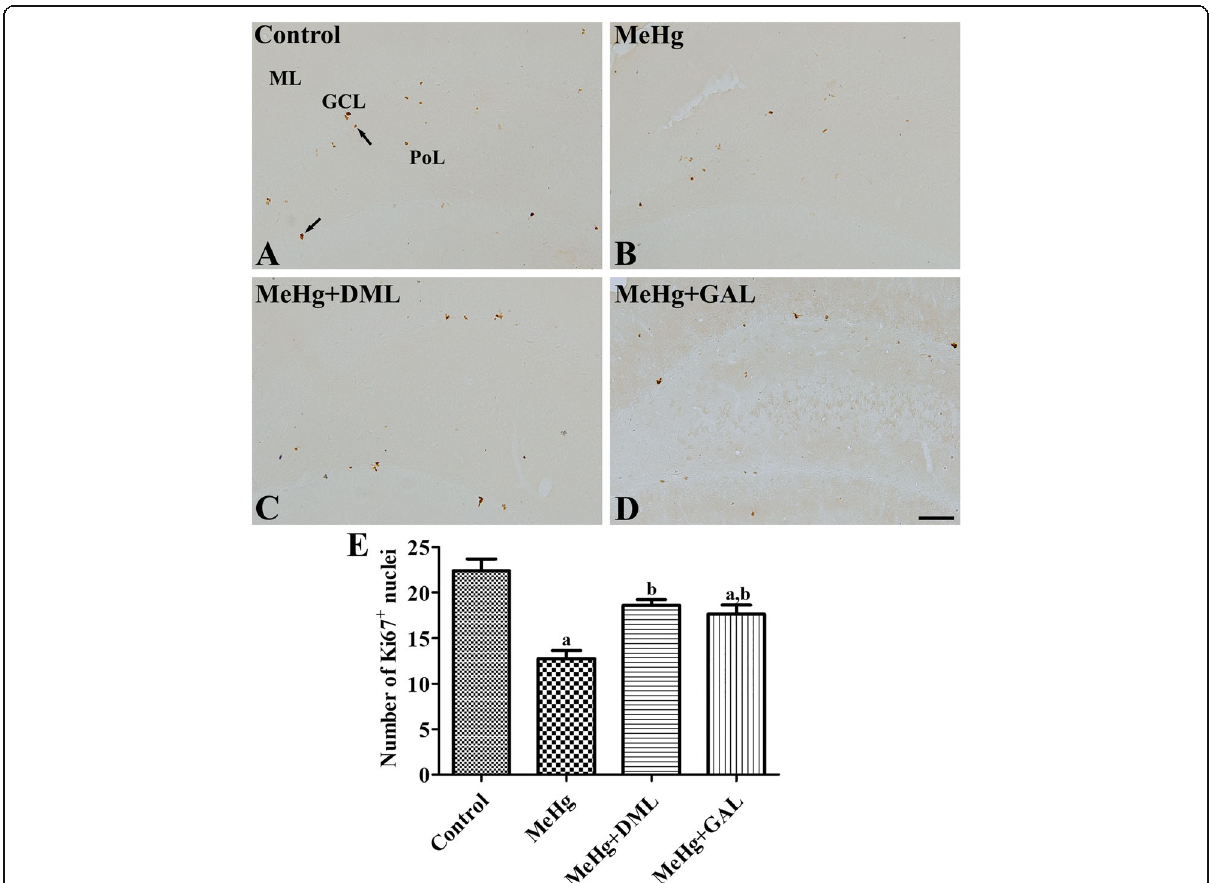
Fig. 3 Immunohistochemistry for Ki67 in the dentate gyrus of the control group ( a ), dimethylmercury (MeHg)-treated group ( b ), Dendropanax morbifera leaf extract treated group with MeHg (MeHg + DML) ( c ), and galantamine (GAL) treated group with MeHg (MeHg + GAL) ( d ). In the control group, Ki67 positive nuclei (arrows) are mainly observed in the subgranular zone of the dentate gyrus. Note that few Ki67 positive nuclei are found in the MeHg-treated group, while in the MeHg + DML-treated group, Ki67 positive nuclei are relatively abundant. GCL, granule cell layer; ML, molecular layer; PoL, polymorphic layer. Scale bar = 100 μ m. ( e ): Quantitative analysis of Ki67 positive nuclei number per section in the control, MeHg-treated, and MeHg+DML-treated rats using an image analyzer (n = 5 per group; ap <0.05, vs. control group; bp < MeHg-treated group). Values are mean ± standard error of the